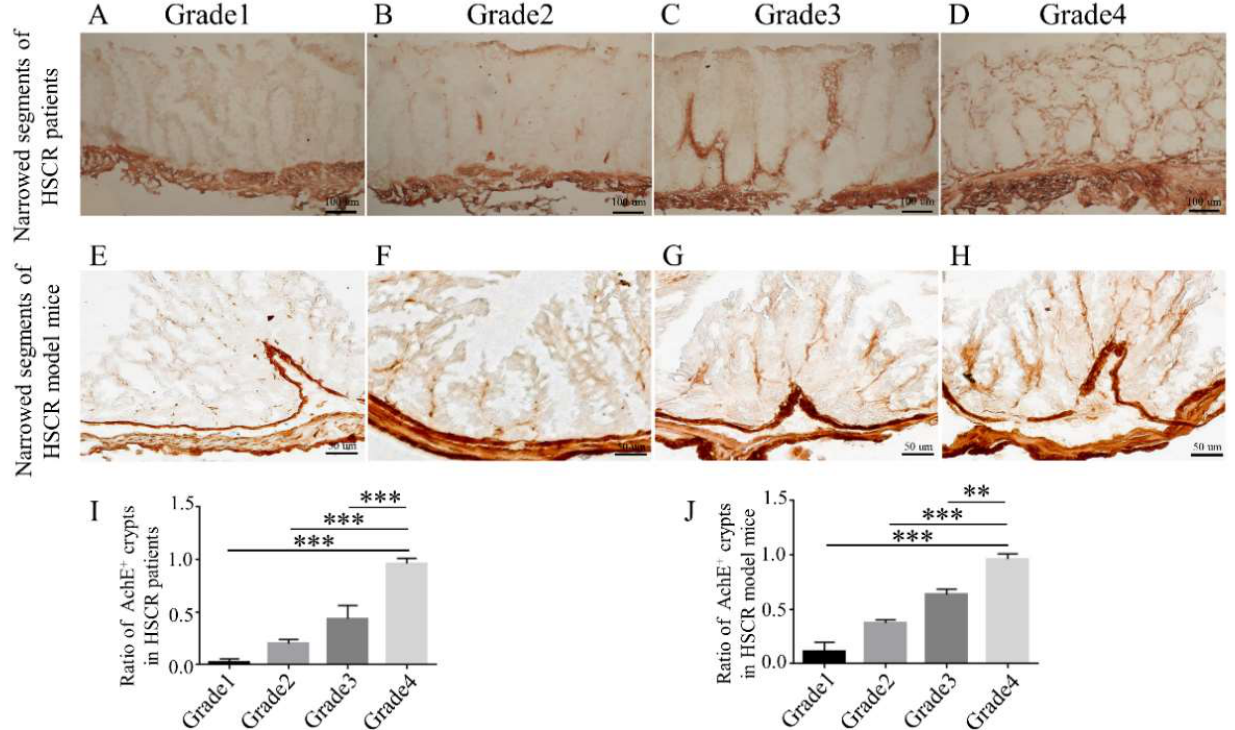
Figure 2. Aganglionic segments of HSCR patients and model mice were divided into four grades according to AChE + nerves. ( A – D ) Different grades of AChE + in colonic aganglionic segments of HSCR patients. ( E – H ) Different grades of AChE + in colonic aganglionic segments of HSCR model mice. ( I , J ) The ratio of AchE + crypts in the colons of HSCR patients and model mice. **, p < 0.01; ***, p < 0.001, one-way ANOVA with Bonferroni post hoc, n = 10.